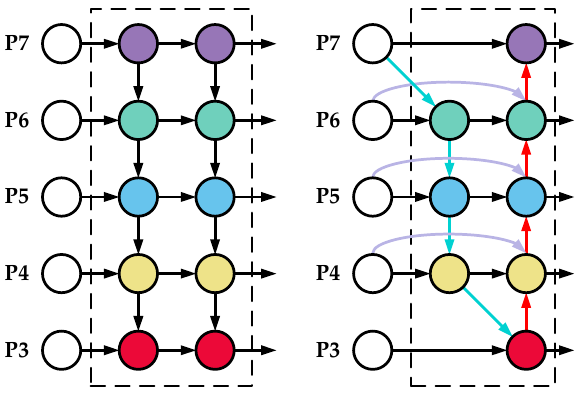
Figure 5. Structure of BiFPN.